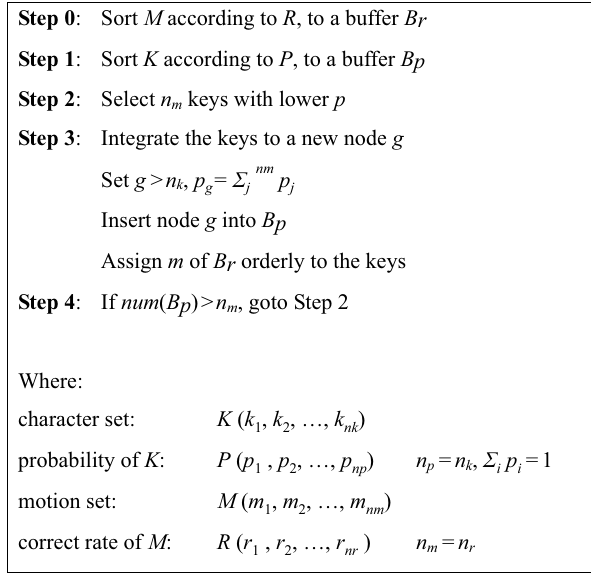
Algorithm 1 The modified Huffman coding algorithm. In steps 0 and 1, the character and motion sets are sorted according to the probability of K and recognition correct rate of motion M , respectively, to code the keys with higher appearance probability, achieving more reliable motions and shorter code